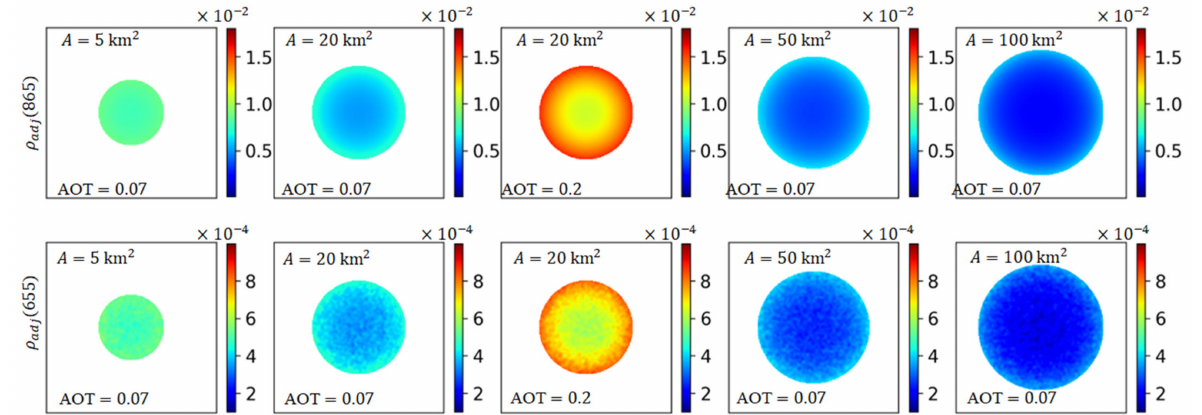
Figure 12. Images of the percent adjacency reflectance ξρ t in 865 nm and 655 nm for lakes with an